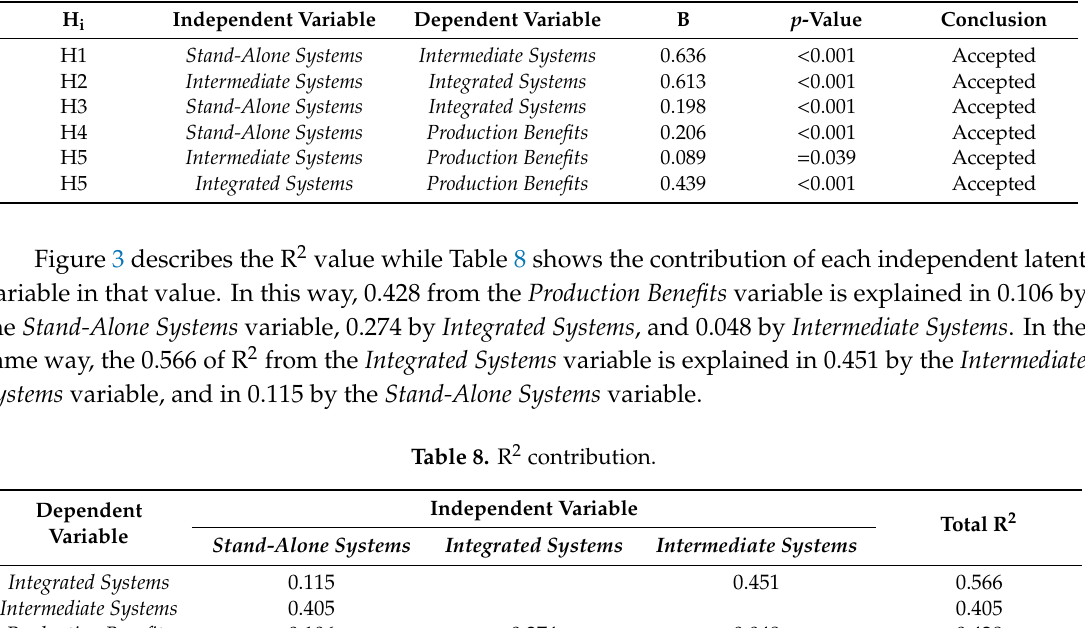
Table 7. Conclusions of the hypotheses.